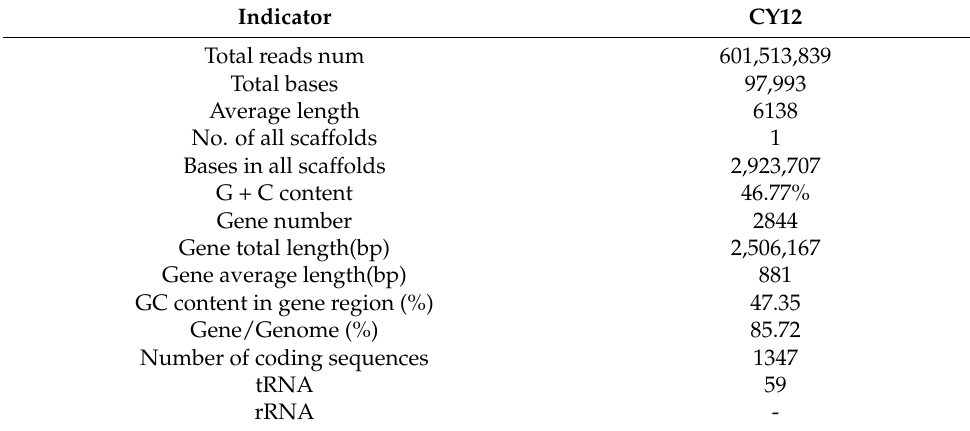
Table 7. General genomic information of the strain